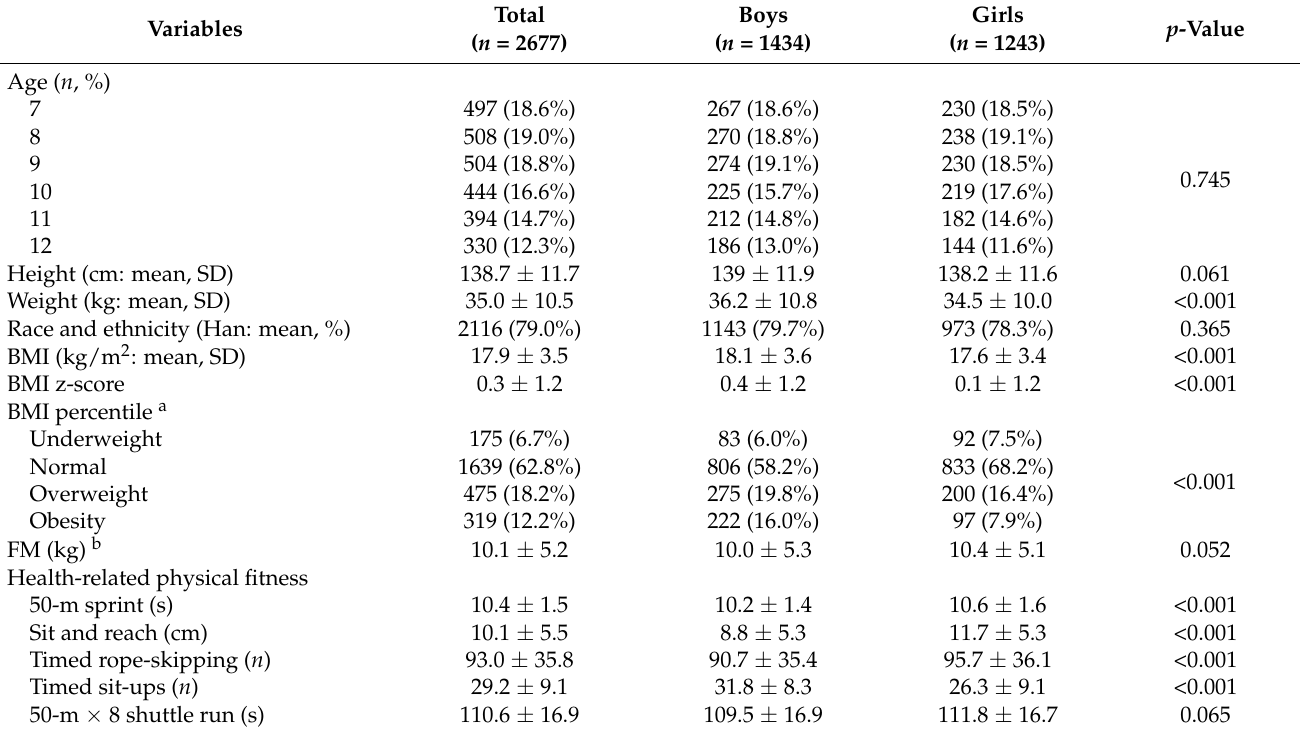
Table 1. Participant characteristics.